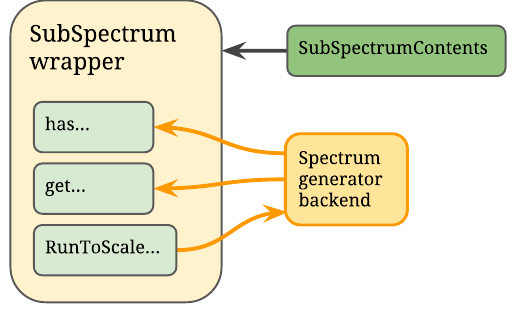
Fig. 5 Schematic representation of a SubSpectrum object. These objects interface directly to spectrum information or external spectrum generators(yellowbox).Accessorfunctions(e.g. has , get )areusedto accessspectrumparameters,and,inthecasewhereaspectrumgenerator is connected, the RunToScale function can be called to run the whole spectrum to a different scale (pale-green boxes). To standardise param- eters that should be retrievable from generated spectra for each model, wedefineaseparate SubSpectrumContents objectforeachmodel. Eachwrapperisthenassociatedwithsome SubSpectrumContents (green box), and is required to provide all the contents defined